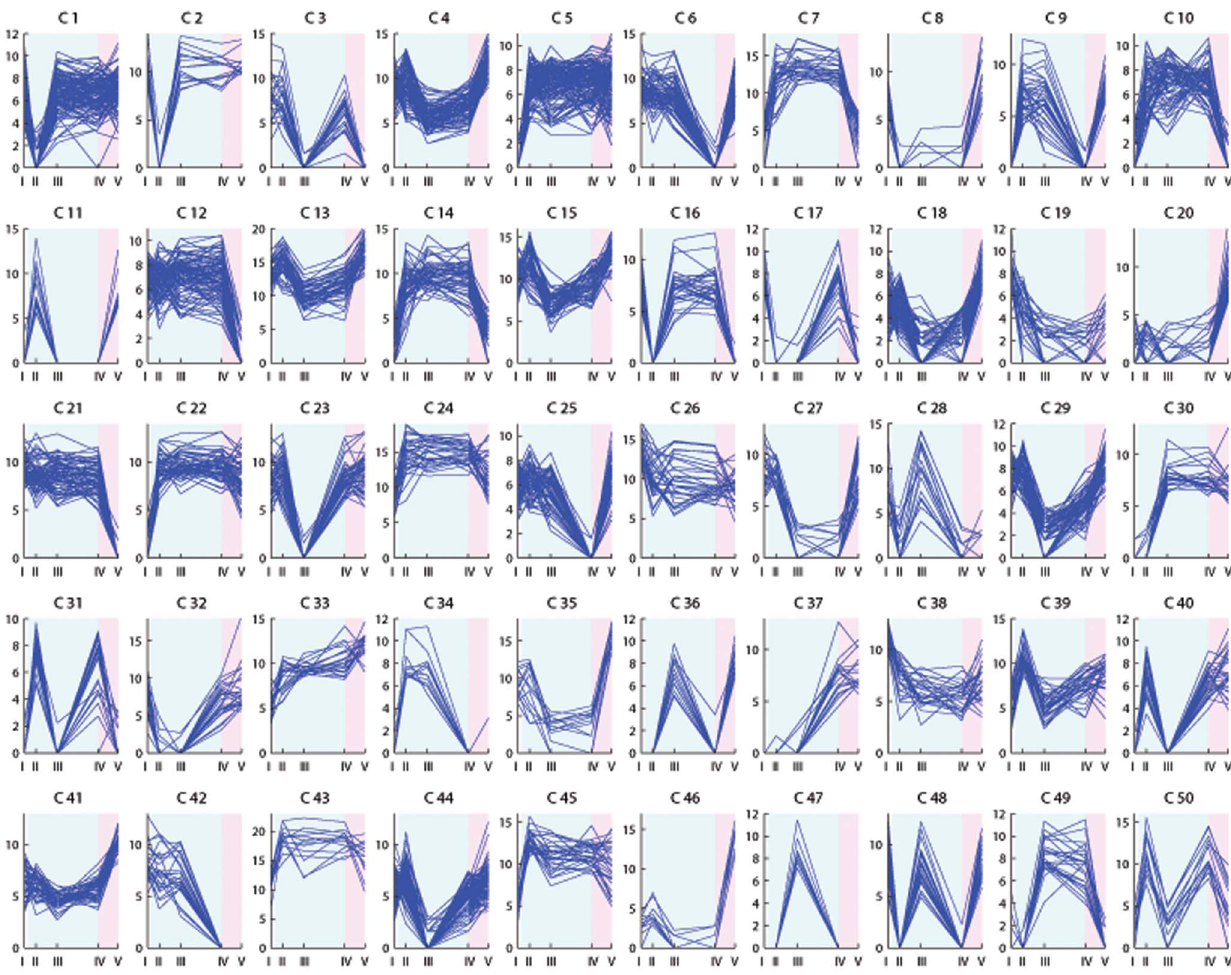
Figure 3. K-means clustering analysis of transcripts differentially expressed in Falster leaf samples. K=50 clusters. The x axis presents the sample collection time points: I= autumn conditions, before the start of vernalization; II=2 days of vernalization; III=4 weeks of vernalization; IV=9 weeks of vernalization; V=7 days of long day conditions. The y axis corresponds to the variance stabilized data from DESeq. The blue background illustrates vernalization treatment, the pink background illustrates long day